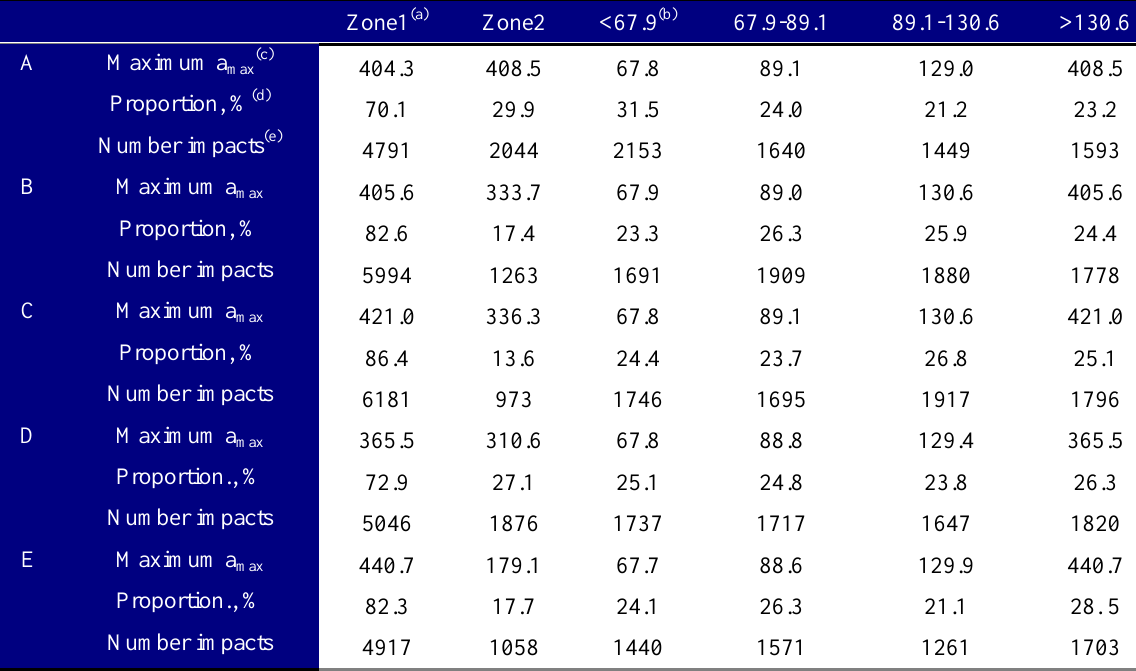
Table 2. Maximum impact acceleration data, proportion of impacts and number of impacts by zone and level for each